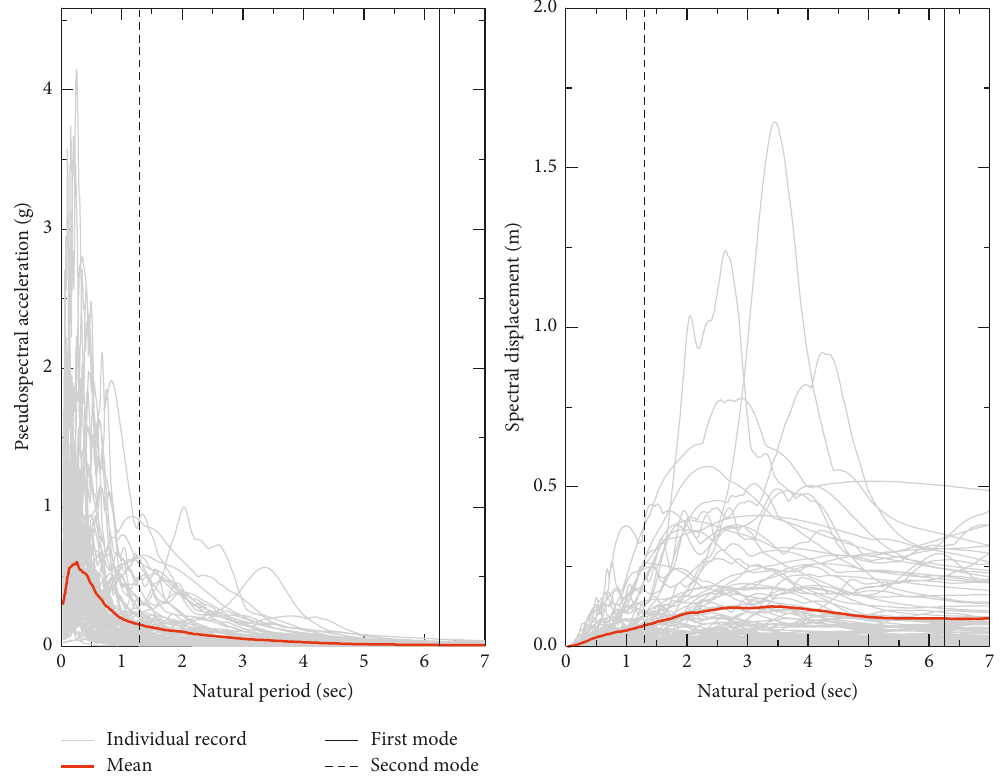
Figure 4: Elastic response spectra (5% damped) of the 100 ground motions used in the study. The average spectra are plotted in red, and the periods of the first two modes of vibration are represented with the vertical